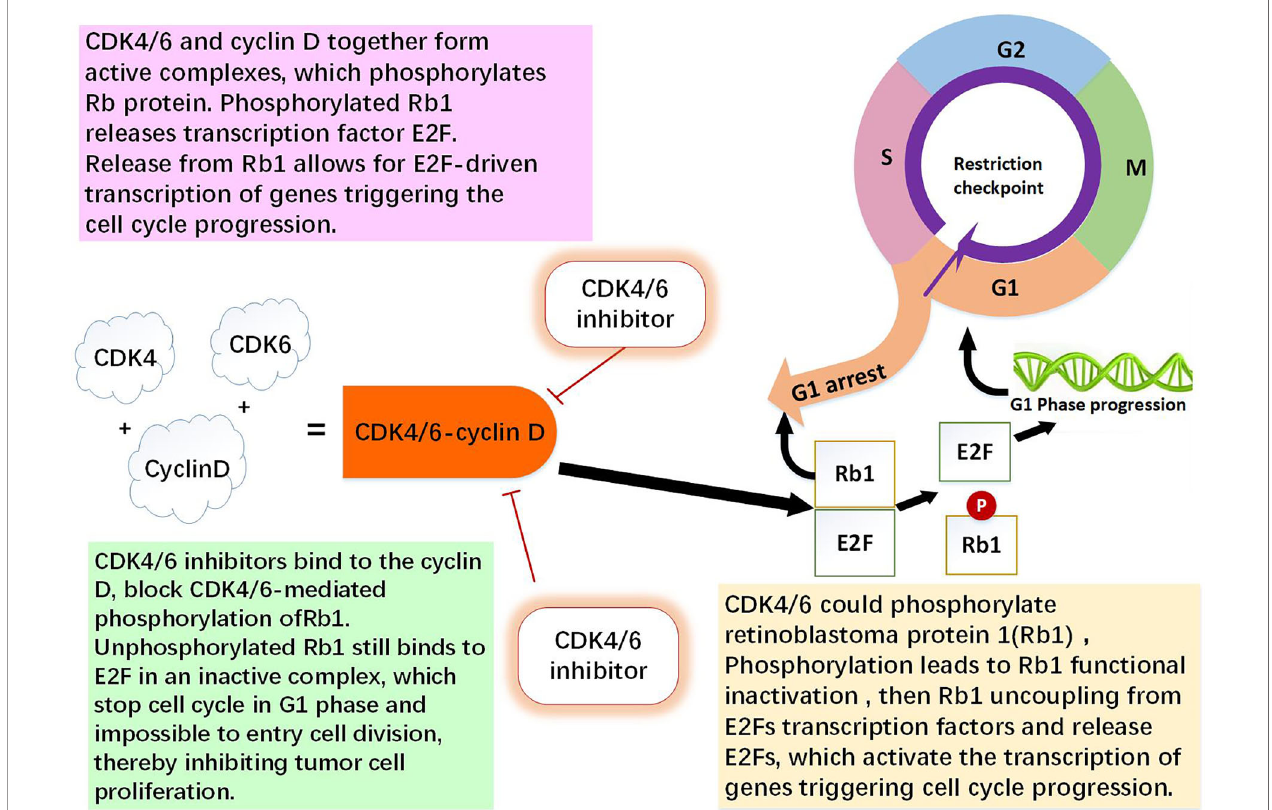
FIGURE 1 | The role of CDK4/6-cyclin D and CDK4/6 inhibitor. CDK4 and CDK6 play key roles in cell proliferation. Cyclin D is regulator of the CDK4 and CDK6 kinases. CDK4/6 and cyclin D together form active complexes, which phosphorylates Rb1 protein. Rb1 is an onco-suppressor which repress the transcription of genes required for the cell cycle, limit the expression of transcription factor E2F target genes which are involved in cell cycle progression. Phosphorylated Rb1 releases E2F. Release from Rb1 allows for E2F-driven genes triggering the cell cycle progression. CDK4/6 inhibitors bind to the cyclin D speci fi cally, thereby block CDK4/6-mediated phosphorylation of Rb1. Non-phosphorylated Rb1 still binds to E2F in an inactive complex, which leading to cell cycle arrest in G0/G1 phase and impossible to entry cell division, thereby inhibiting tumor cell proliferation (1, 9, 10,